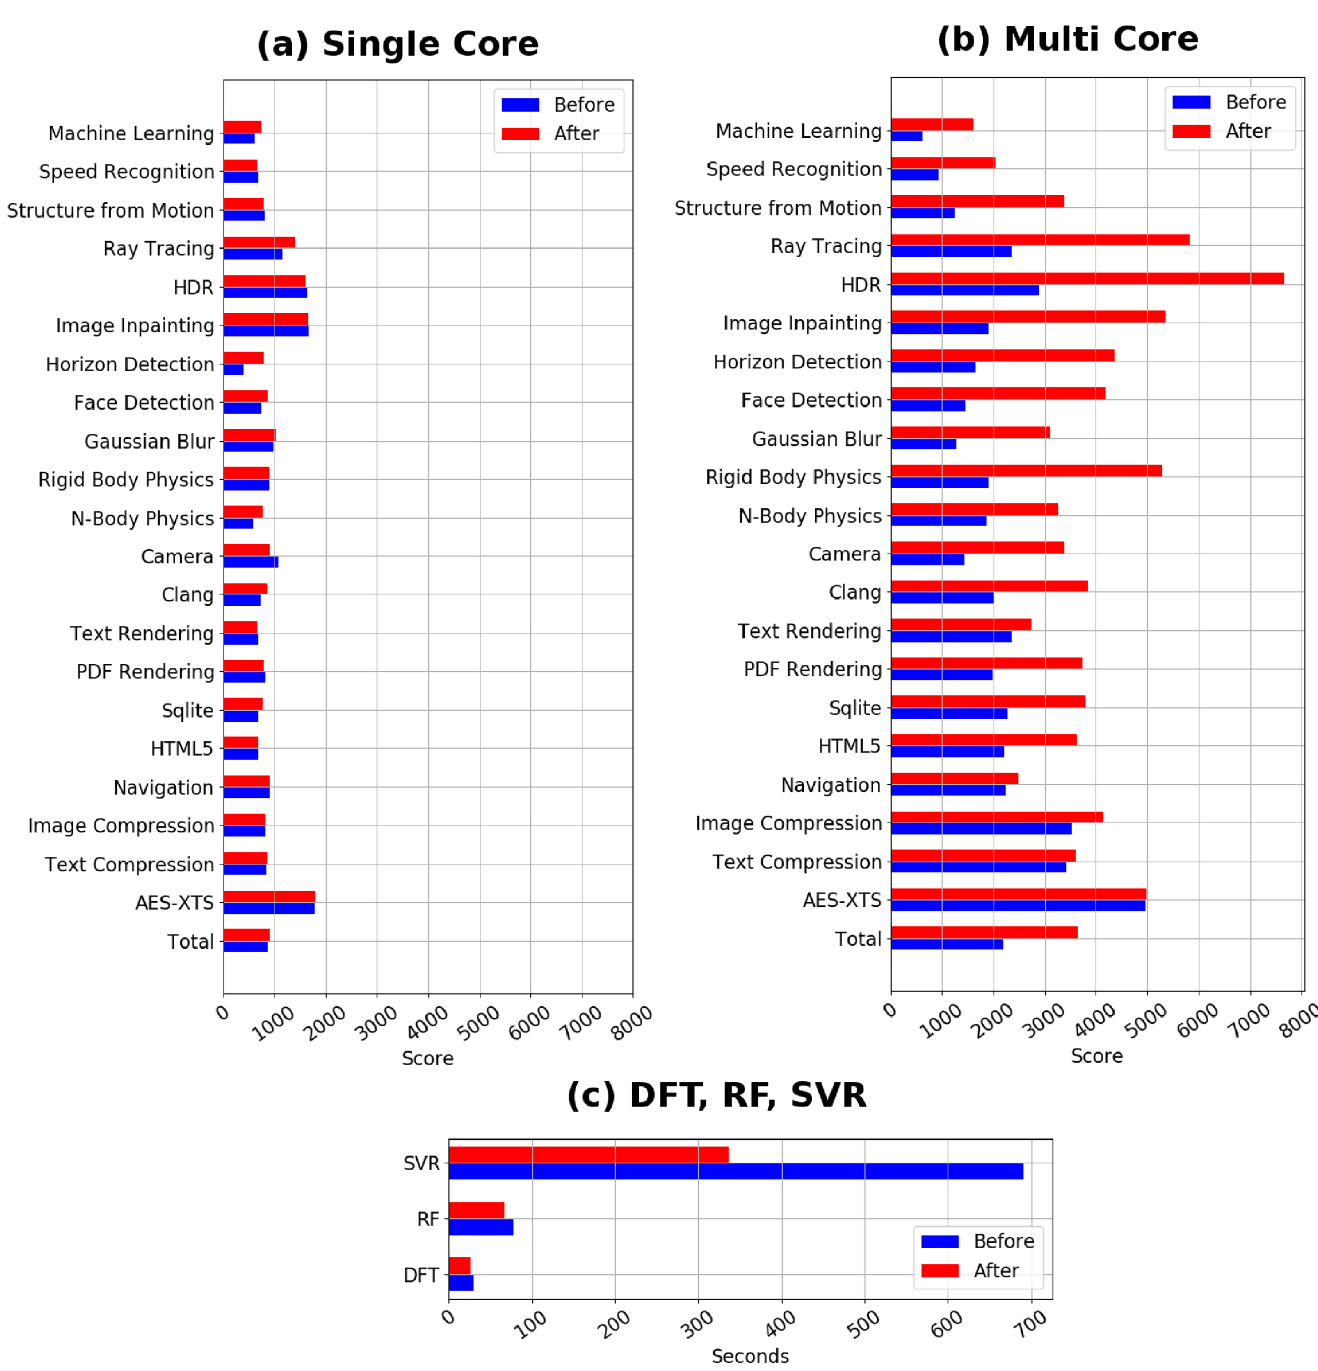
Fig 2. Benchmark tests by Geekbench 5 with and without the transformer oil (a) single core and (b) multi core test results by Geekbench 5, and (c) density functional theory (DFT), random forest (RF), and support vector machine (SVR) single core calculations where computational time is evaluated with and without the presence of transformer